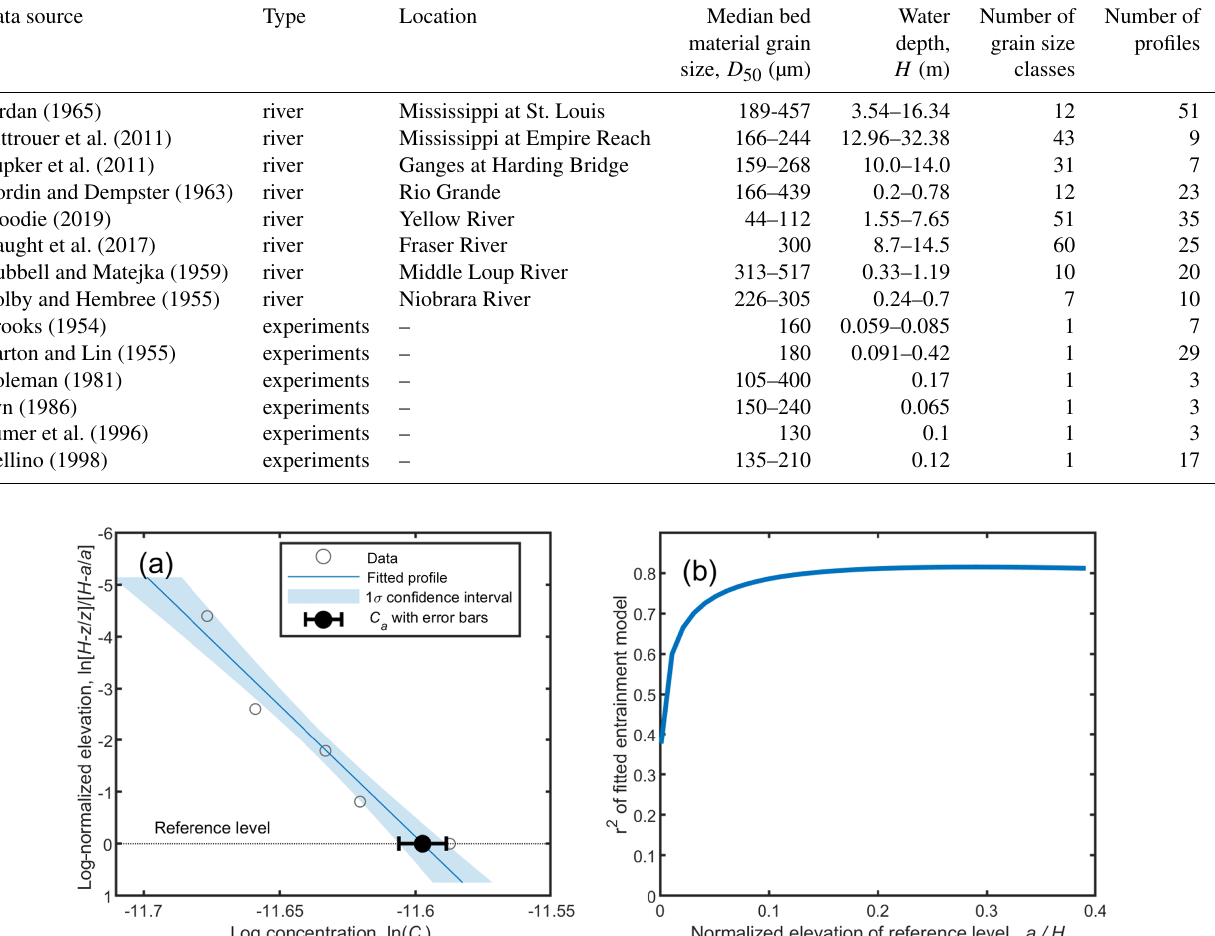
Figure 4. (a) Example of suspended sediment data linearized in Rouse coordinates with a fitted Rouse profile (Eq. 1), in which z is the elevation above the bed, H is the flow depth, and extrapolation to the reference level at z = a gives the reference concentration, C a . (b) Effect of the choice of reference level elevation on the r 2 of the best-fit entrainment relation, E s i , to the